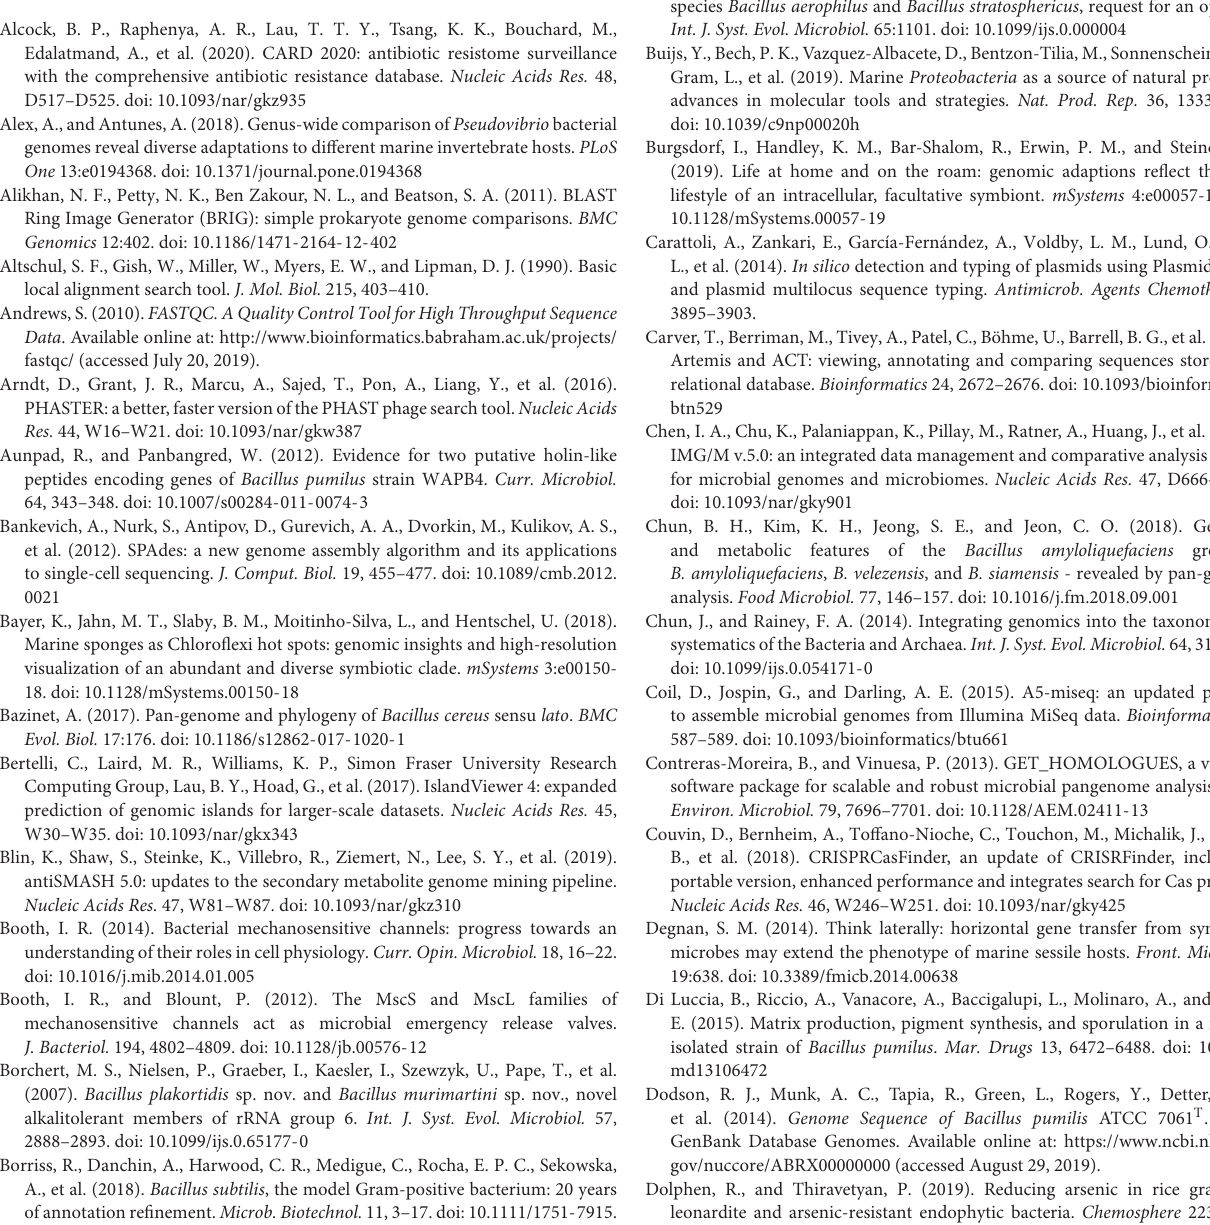
Supplementary Table 2 | The overall genome-related index (OGRIs) values from different in silico bioinformatics tools among B. pumilus 64-1 versus members from the B. pumilus group and aquatic-derived B. pumilus strains. Supplementary Table 3 | List of relevant polyssacharide-degrading CAZymes identified in the B. pumilus 64-1 genome. Supplementary Table 4 | List of genes related to antimicrobial resistance and metal tolerance/detoxification annotated in the B. pumilus 64-1 draft